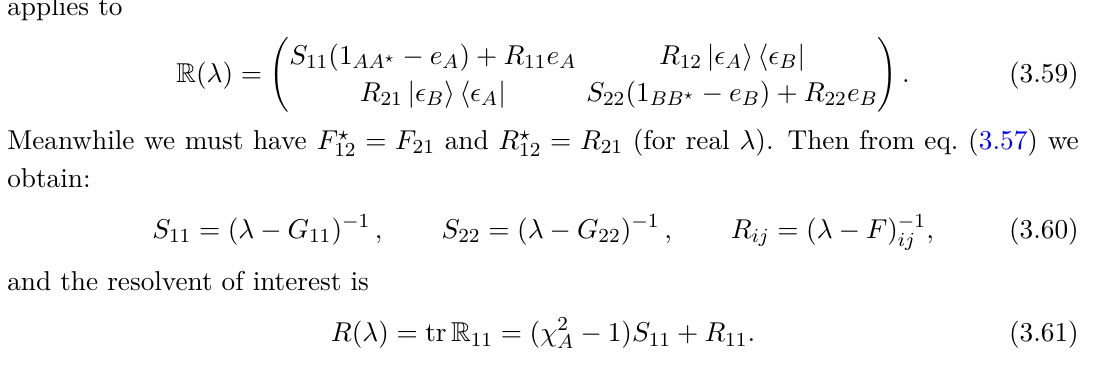
Figure 12 . Example contractions of the diagram that give rise to the projector or the identity, where it should be clear that all the possible diagrams are either proportional to identity operator 1 1 , or one of the four projectors | (cid:15) . AA ∗ , BB ∗ A,B i h (cid:15) A,B | where | (cid:15) i = χ − 1 / 2 | 1 i is the maximally mixed state on AA ∗ (same for | (cid:15) A A A and e = | (cid:15) i h (cid:15) | are normalized minimal projectors and F is a 2 × 2 matrix of scalars B B B (not to be confused with F ). Also 1 is the identity acting on H AA ?